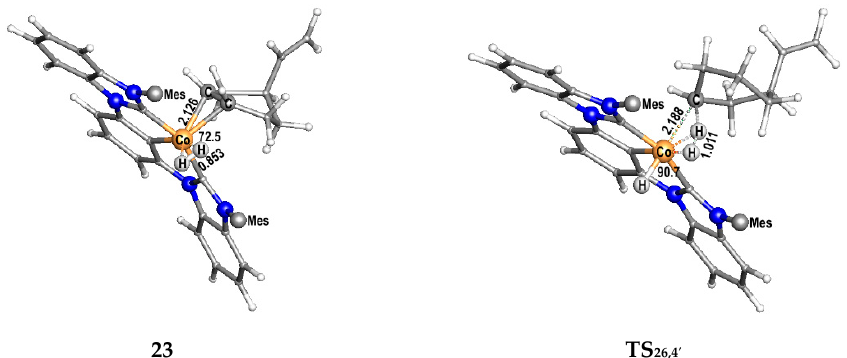
Figure 12. Optimized structures of 23 and TS 26,4 ′ (1033 i cm − 1 ). Mesitylene groups are omitted for clarity. Bond lengths are in Å, and bond angles are in °.